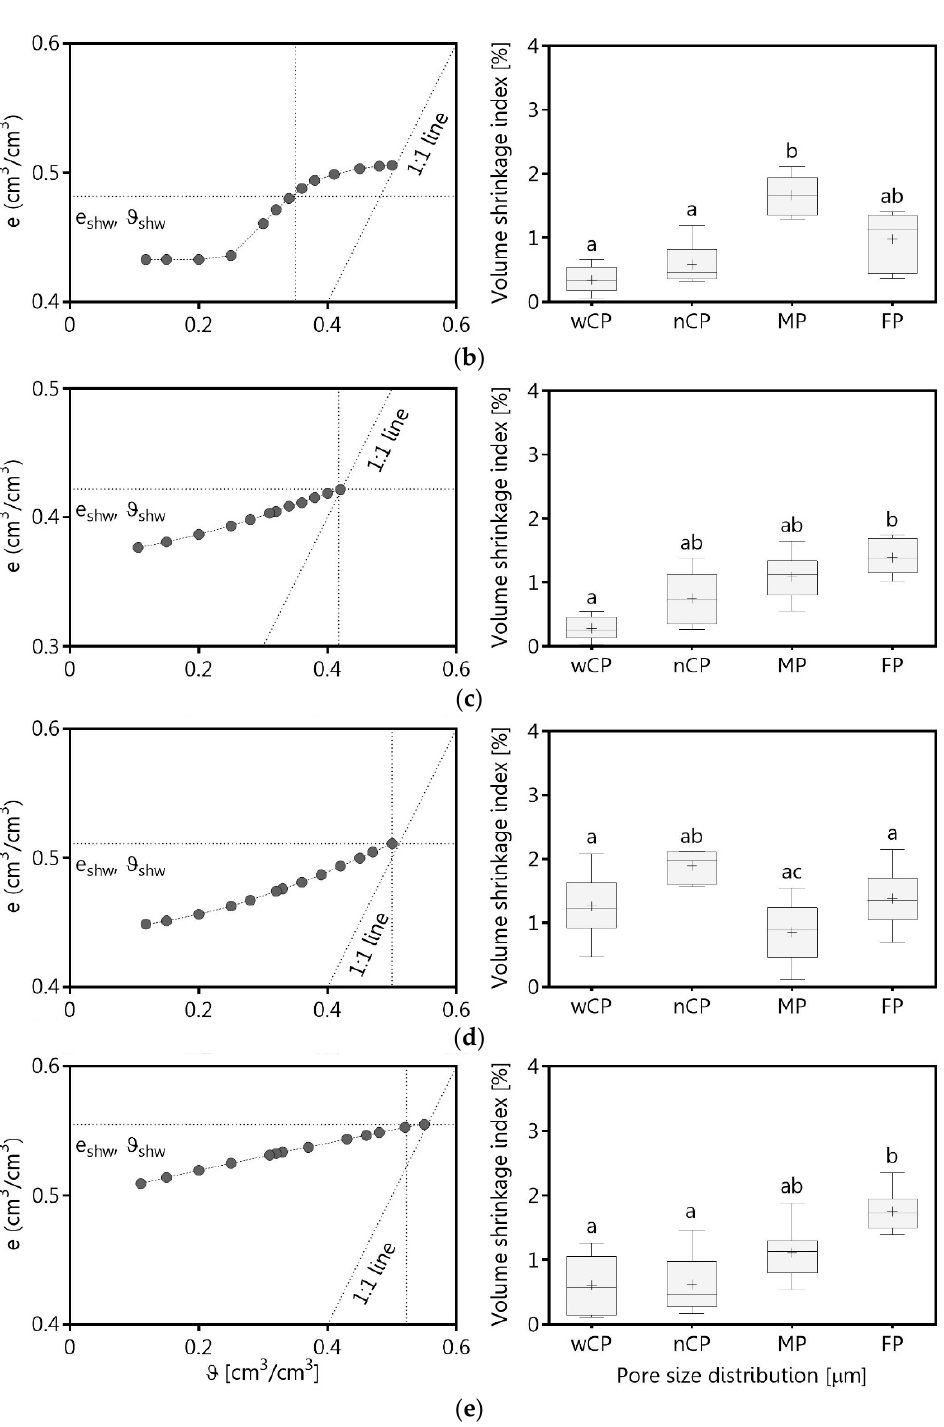
Figure 3. Shrinkage curves and volume shrinkage index of the wide coarse (wCP), narrow coarse pores (nCP), medium (MP), and fine pores (FP) of the five different Proctor stages: ( a ) bm1, ( b ) bm2, ( c ) bm3, ( d ) bm4, ( e ) bm5. Different letters indicate statistically significant differences ( p < 0.05) of the volume shrinkage index in comparison to the pore size. The transition point between the structural and the proportional shrinkage phase is marked with dashed lines (e shw and ϑ shw ).